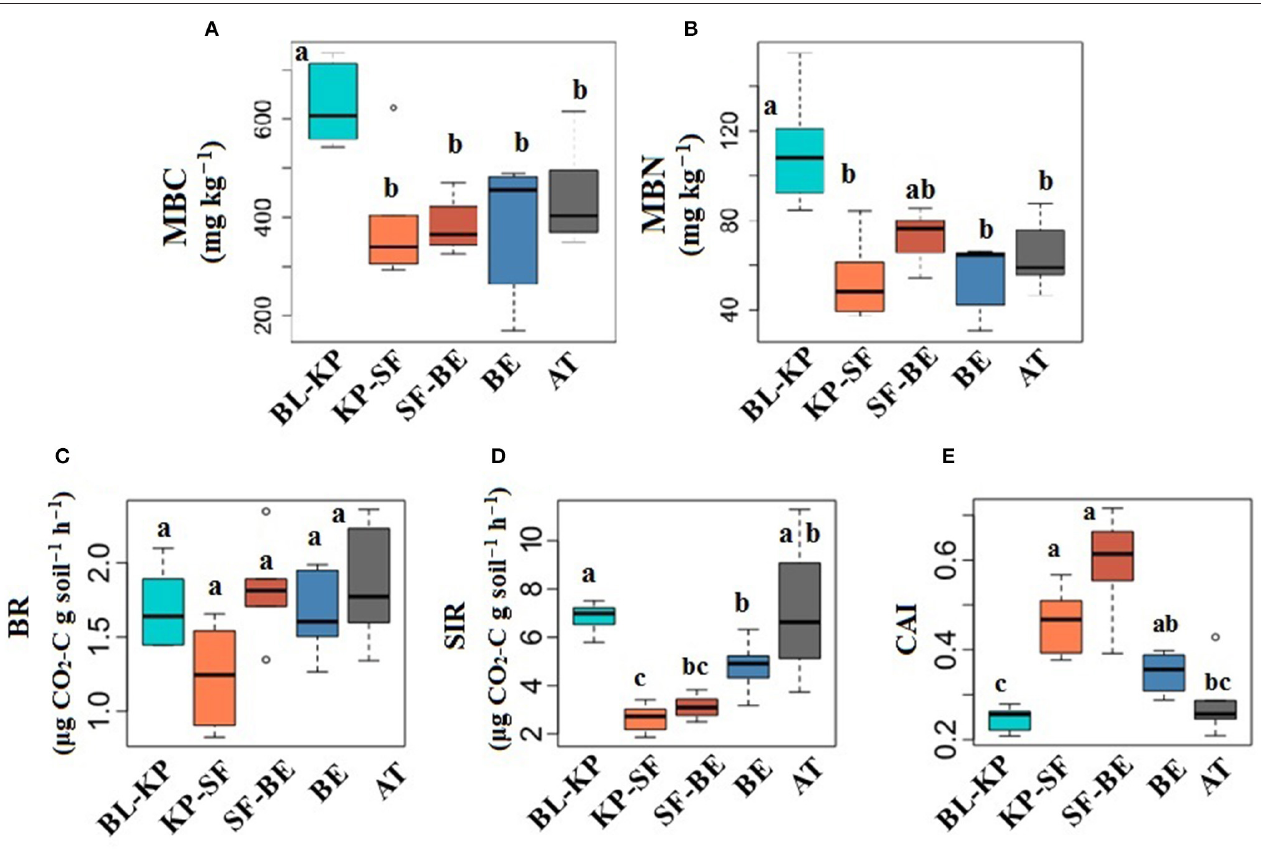
FIGURE 1 | Changes in soil microbial biomass (A) microbial biomass carbon, MBC; (B) microbial biomass nitrogen, MBN; and soil respiration (C) basal respiration, BR; (D) substrate induced respiration, SIR; (E) carbon availability index, (CAI) under different vegetation types along an elevational gradient in Changbai Mountain. Different letters indicate significant differences ( t -test, P adjust < 0.05) between